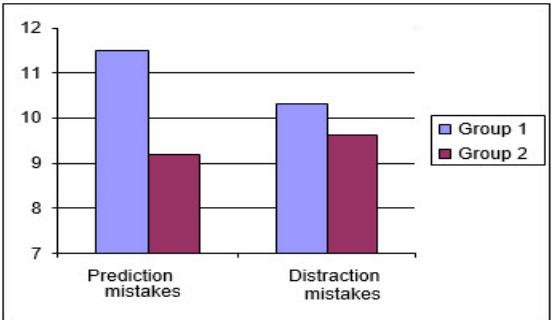
Figure 2. The success of reproduction Figure 1. Mistakes of prediction and of elements sequences in the forecasting pro- distraction made in the forecasting process by cess of preschool children in percentage preschool children Indicators II and III allow to approach indirect and direct characterization of the ef- ficiency of memorizing and storing informa - tion in the register of short-term memory, on the one hand, and reproduction of information that came for storage to the long term memory, on the other hand. The difficulty in reproduc - ing the sequence of earlier correctly predicted elements may indicate a violation of neuro- physiological mechanism, which provides di- rectional “reading” of information from mem - ory (Переслени Л. И., Рожкова Л. А., 1990). The analysis of the strategies that were chosen by the children in educational activi-